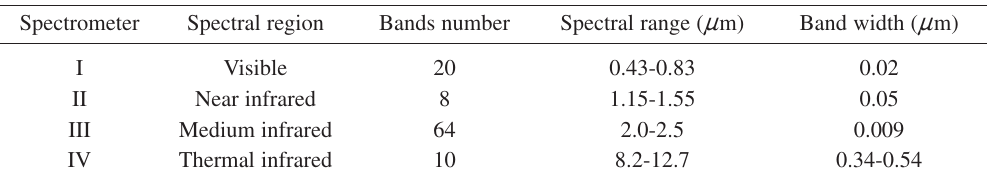
Table I. MIVIS spectral characteristics.